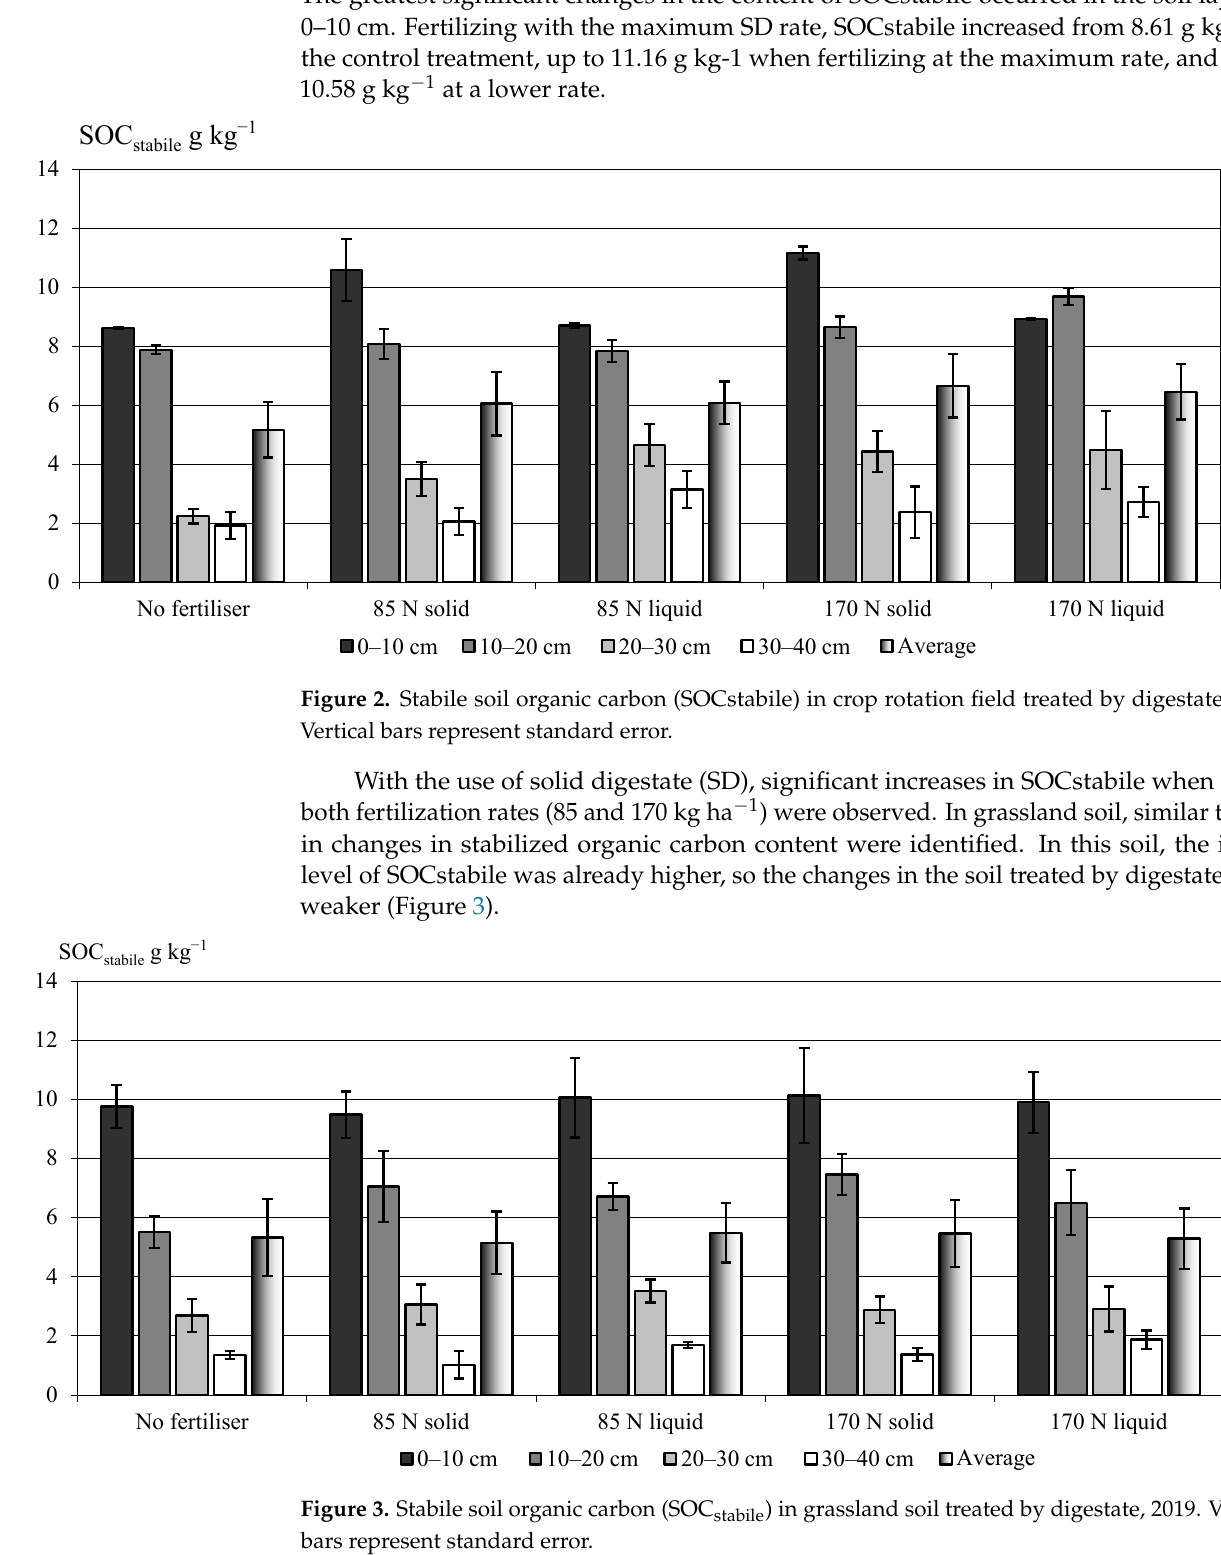
Figure 4. Stabile soil organic carbon (SOCstabile) in crop rotation field treated by digestate, 2020. Vertical bars represent standard error. Unlike the crop rotation field, grassland soil layers were not mixed, and the higher accumulation of SOCstabile in the upper layer of soil (0–10 cm) remained (Figure 4). Thus, in grassland soil, all treatments formed higher levels of SOC compared to the crop rotation field. Treating by digestate maintained these higher SOCstabile levels compared to the crop rotation field, and even increased the levels even higher. Figures 3 and 5 show that in the grassland soil in both years of study, the maximum accumulation of SOCstabile in a layer of 0–10 cm (10.11–10.13 g kg − 1 ) was obtained by fertilizing with a maximum rate of 170 kg ha − 1 SD, as well as LD, which was analogous, being only slightly less. Both the liquid and solid fractions of digestate contain valuable components for plant growth during the vegetation period [38]. However, the LD fraction contains less TS com- pared to the SD fraction. As a result, the LD fraction has more potential to migrate into deeper soil layers compared to the SD fraction. This is in line with the data obtained by